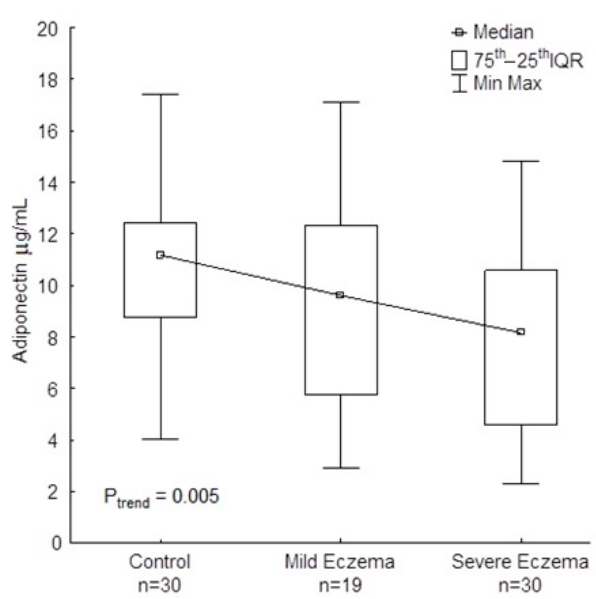
Figure 1. Blood adiponectin in patients mild and severe atopic eczema and healthy controls. IQR, interquartile range.